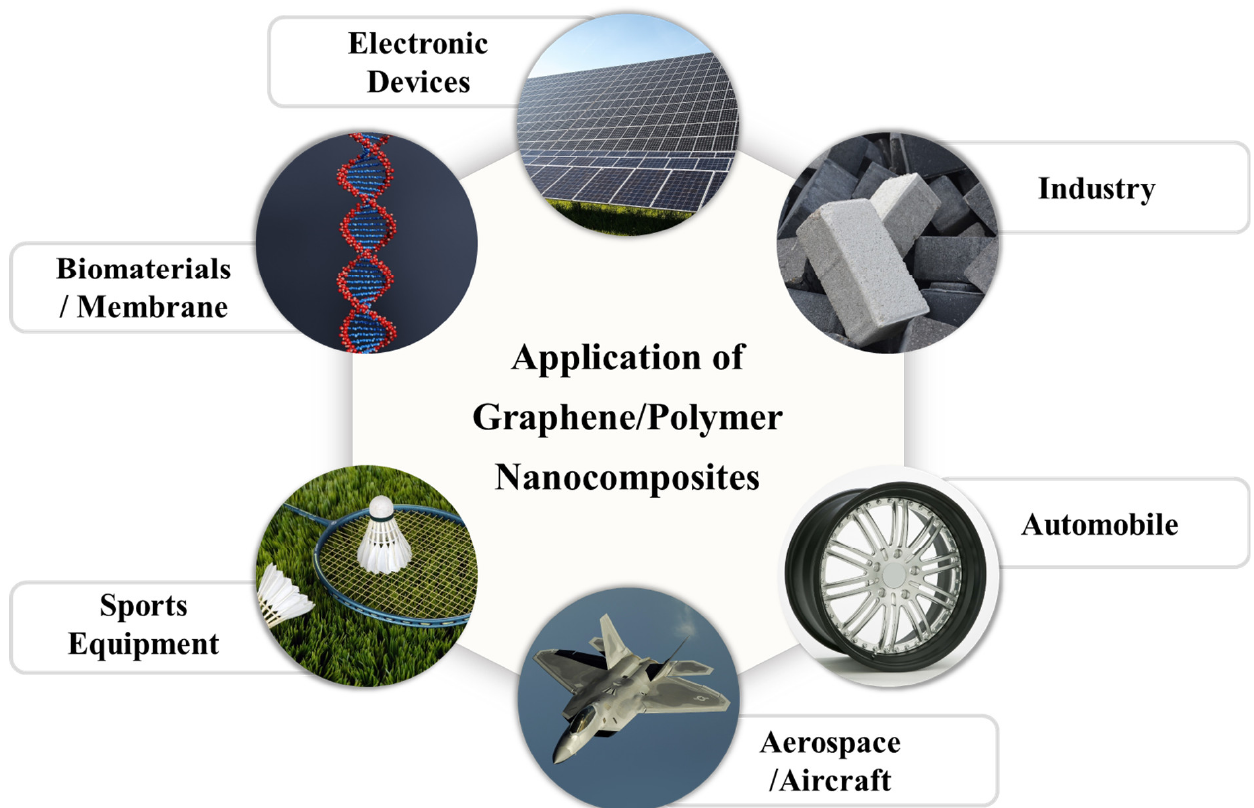
Figure 8. Applications of graphene/polymer nanocomposites.